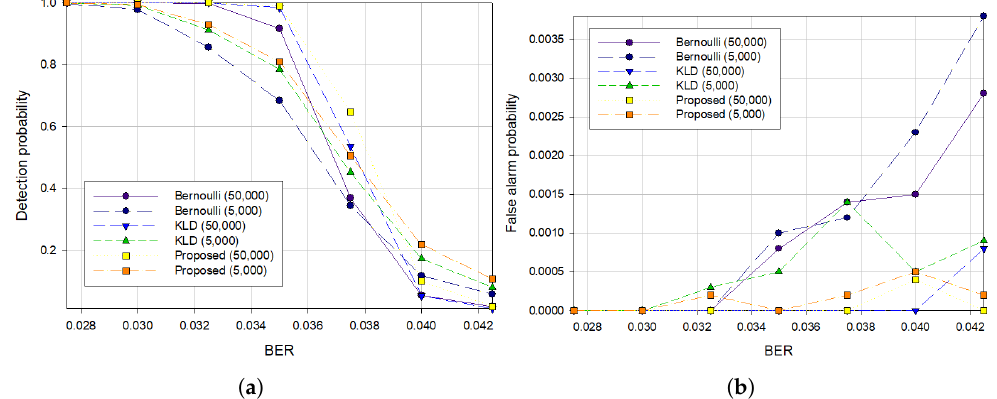
Figure 7. Results with Hamming (7, 4) code when S = 35 ( a ) the detection probability, ( b ) the false alarm probability according to the length of bitstreams.